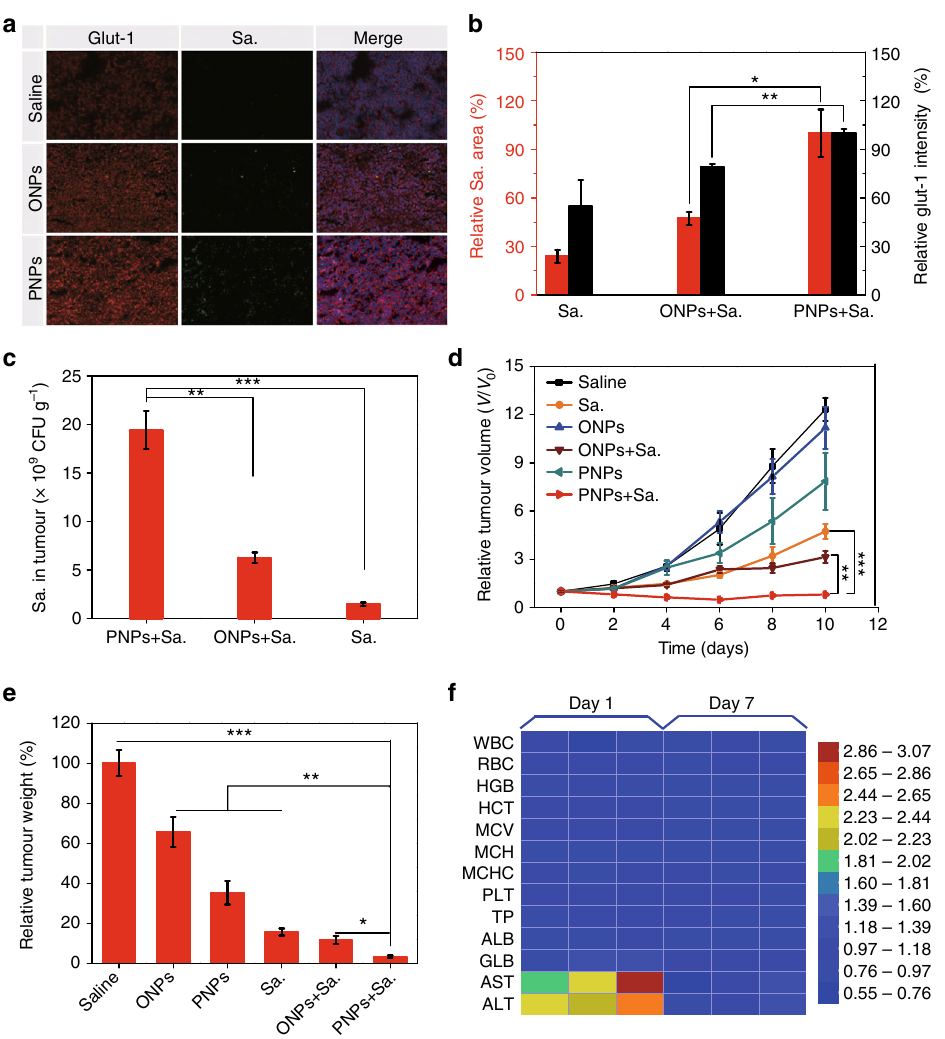
Fig. 5 PNPs enabled hypoxia-based bacterial cancer therapy. a The hypoxia intensity, Salmonella VNP20009 (Sa.) accumulation and nuclei were determined by staining with anti-glut-1 antibody (red), anti-Sa. antibody (green) and 4 ′ ,6-diamidino-2-phenylindole (DAPI) (blue), respectively (scale bar, 100 µ m). Sa. (5 × 10 6 CFU) was intravenously administered to mice 1 h before irradiation. The mice were exposed to the laser (808 nm, 400 mW cm − 2 ) for 5 min at 24 h after they were intravenously injected with PNPs, oil nanoparticles (ONPs) or saline. Immuno fl uorescence images of tumour sections were analysed on day 3 post irradiation ( n ≥ 3). b Semiquantitative analysis of the relative hypoxia intensity (the black y -axis) and Sa. distribution (the red y -axis) in a . c The distribution of Sa. in tumours was also measured by colony-forming assay on day 3 ( n = 3). d Tumour growth curves of mice subjected to different treatments ( n = 4 – 9). e Normalized tumour weight at day 10 post treatment. f Haematologic indexes and blood biochemistry of mice that were intravenously injected with VNP20009. The experiment was carried out on days 1 and 7 after the injection of VNP20009 (5 × 10 6 CFU mouse − 1 , n = 3) and saline. Values are the mean ± s.e.m. * p < 0.05, ** p < 0.01, *** p < 0.001 (unpaired, two-way t tests). Source data are provided as a Source Data fi